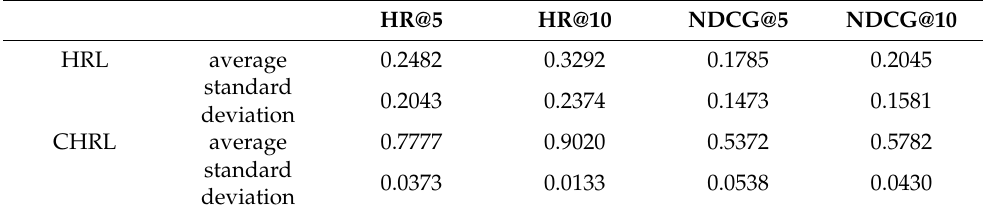
Table 5. The average and standard deviation of HRL and CHRL.